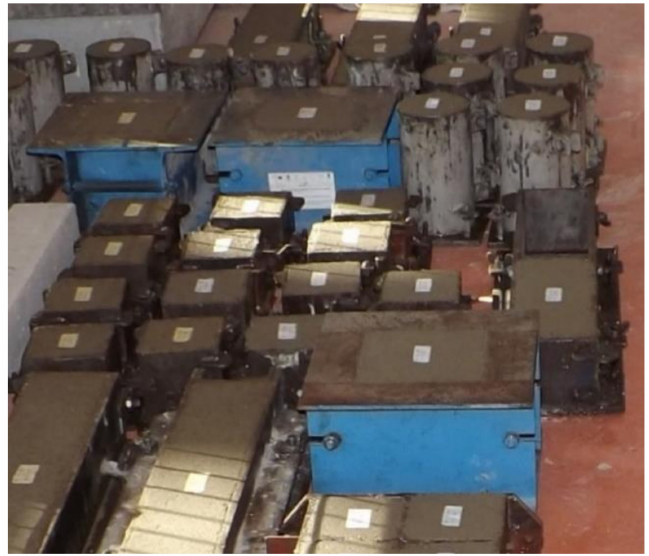
Figure 3. Composite specimens of a developed mix, in